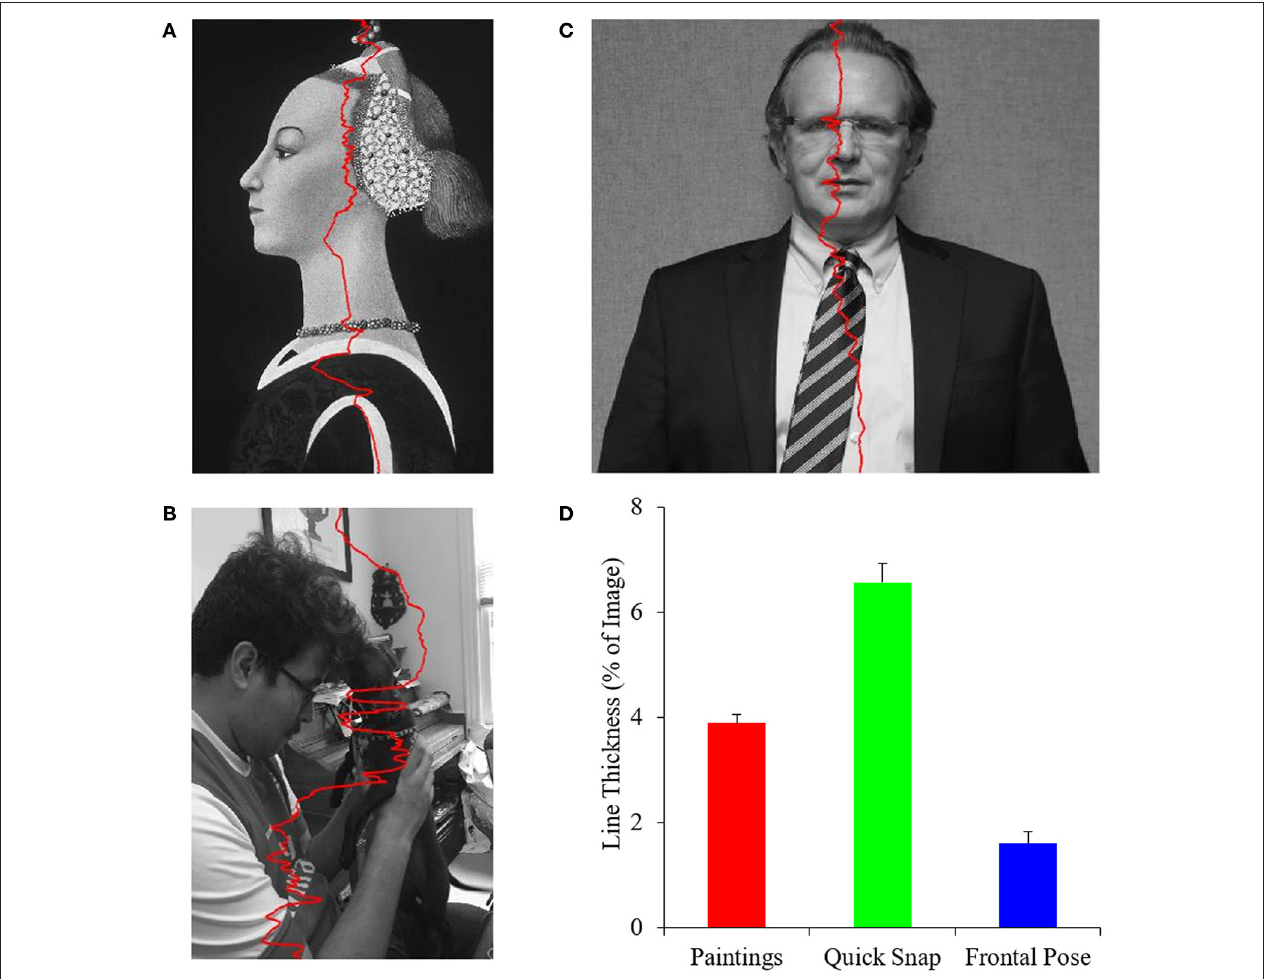
FIGURE 3 | The precision of integral balance in paintings. (A–C) Examples of row-by-row balance lines (Equation 8) in Portrait of a Lady by Paolo Uccello (reprinted here thanks to the Open Access for Scholarly Content designation by the © Metropolitan Museum of Art, New York, United States), a quickly snapped photograph, and a frontally posed control respectively. The superimposed red curves are the balance lines. (D) Mean and standard error of balance-line thicknesses (Equation 9) for the different categories of images. Portrait artists of the Early Renaissance balanced paintings to a greater precision than quickly snapped photographs but not as well as in frontally posed